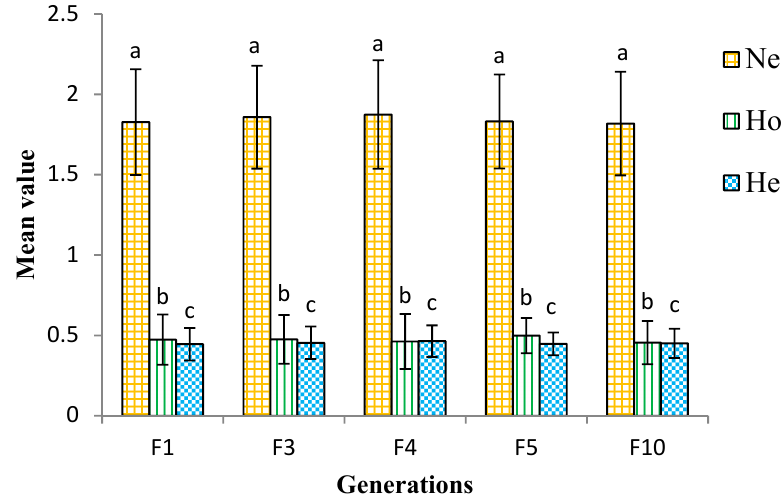
Figure 2. Comparison of genetic parameters among five populations. Means of exposure sharing a common letter are not significantly different at p > 0.05 as assessed using a one-way ANOVA followed by Dunnett’s test.